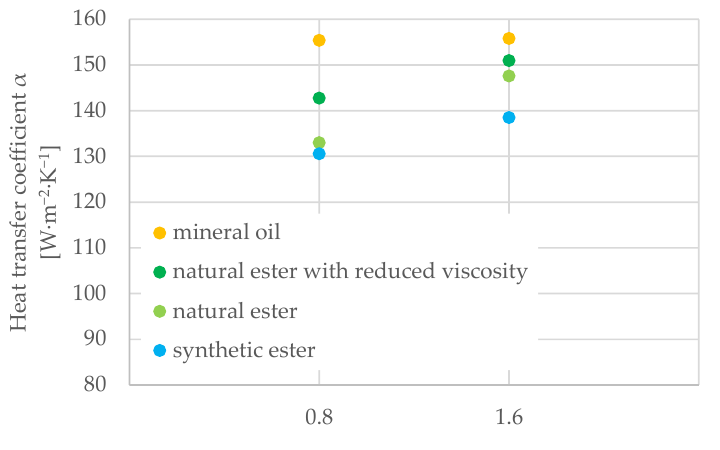
Figure 10. The heat transfer coefficient α depending on the length of the heating element δ for different types of electrical insulating liquid, and the heat load of the cooled surface q = 3000 W · m − 2 .